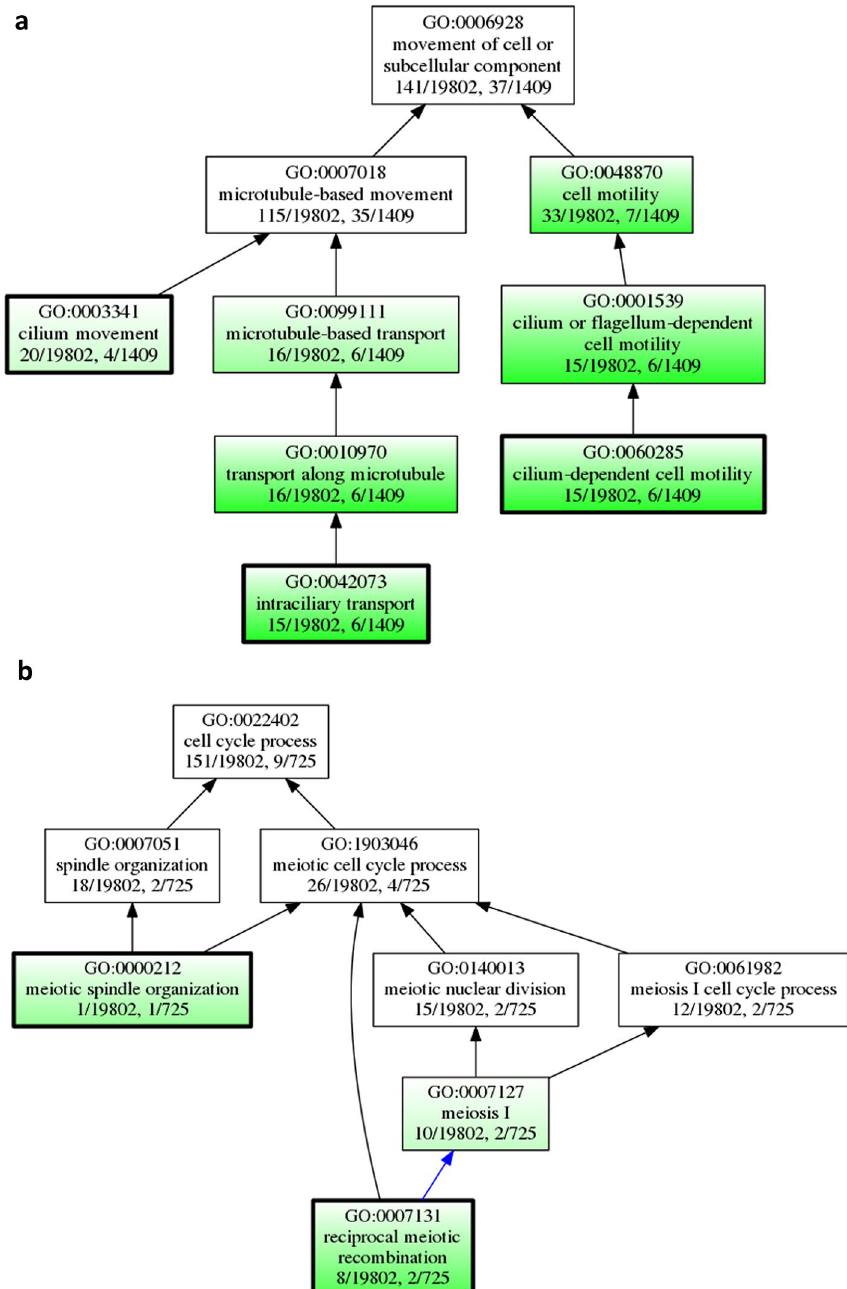
Figure 5. Functional GO enrichment analyses of uniquely expressed genes in resistant and sensitive strains. Subgraphs of some enriched terms are shown: ( a ) GO analyses of cell motility process and related cilium terms, enriched in CCMP373 uniquely expressed genes. ( b ) GO analyses of meiosis related terms, enriched in CCMP374 and CCMP2090 uniquely expressed genes. Terms in green are significantly enriched. The colored arrows signify special relationships: blue is a “part of” the next term